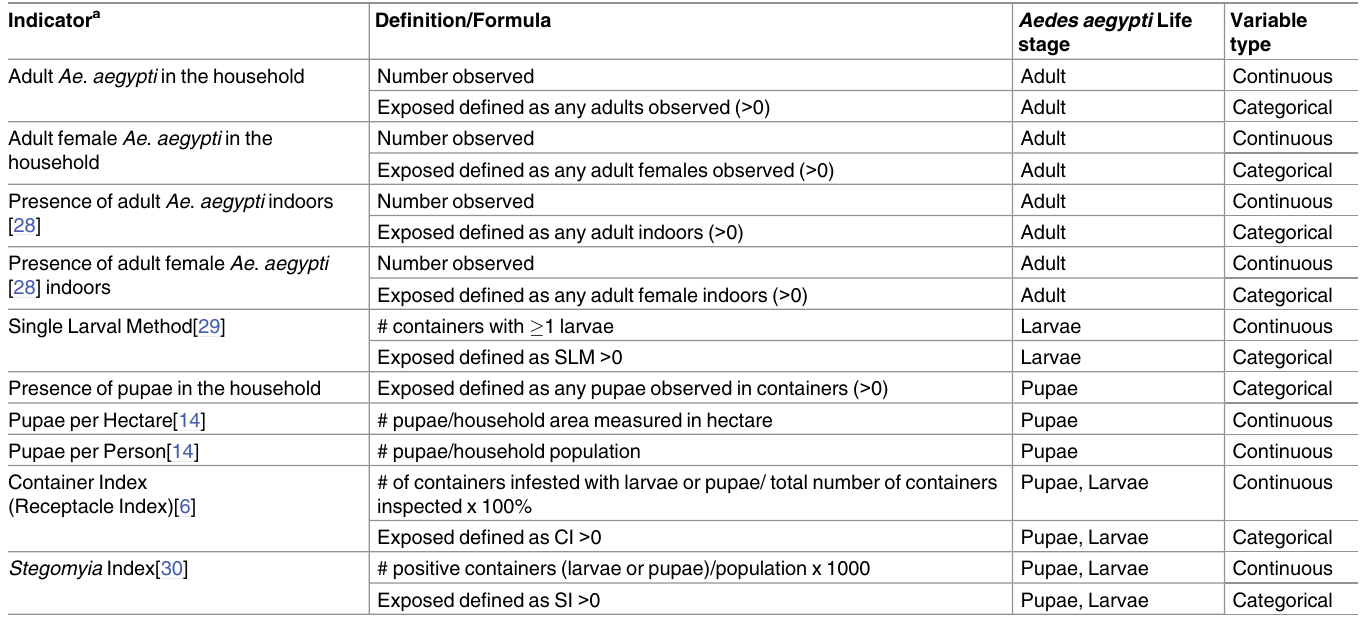
Table 1. Summaryof household-level indicators of Aedes aegypti tested for an association with seroconversion to